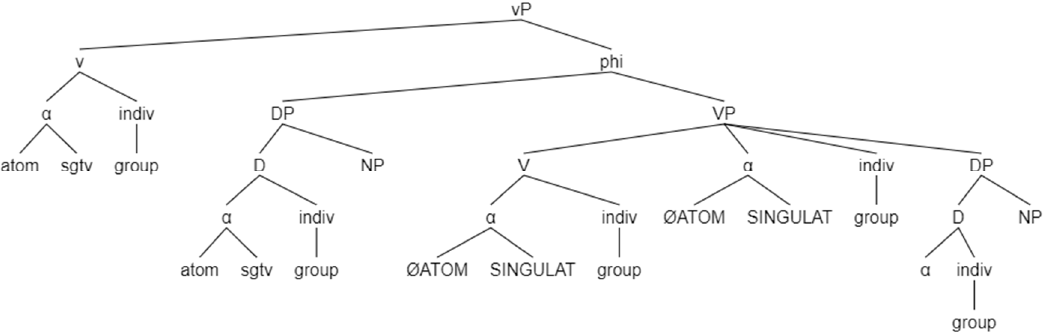
Figure 31. After insertion of v*, inheritance, Agree, and labeling.